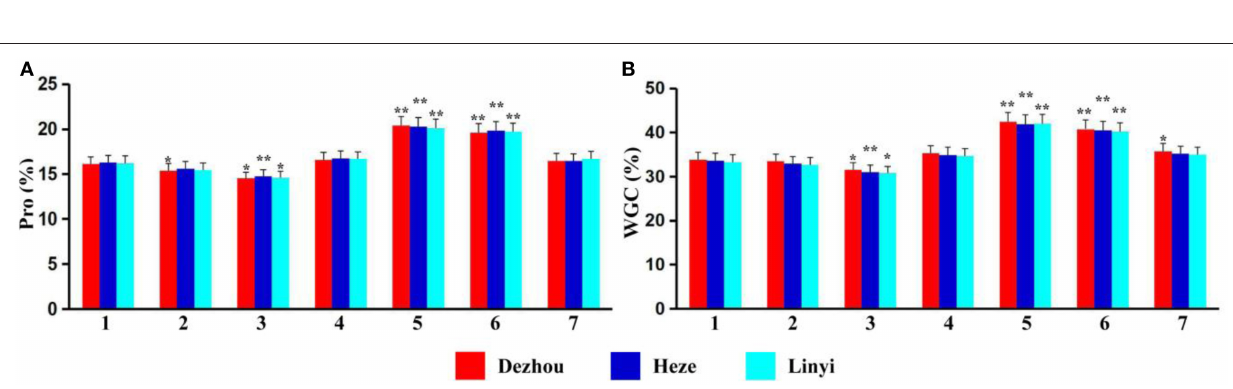
FIGURE 2 | Protein and wet gluten contents of the material tested. Pro (A) , Protein; WGC (B) , Wet Gluten Content; 1–7 represent T. aestivum cv. Alcedo, Alcedo- Ae. caudata B to G addition lines. *significant at P < 0.05 by t -test as compared to relative data of ALCD; **significant at P < 0.01 by t -test as compared to relative data of ALCD. Bar represents standard